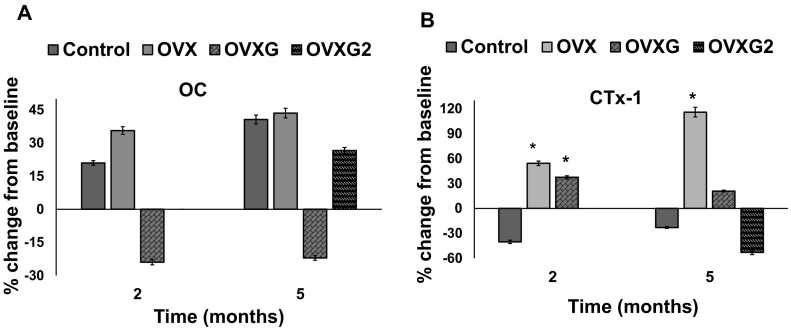
The concentrations of OC and CTx-1 in the serum of the OVX sheep. Percentage change in the bone turnover marker serum OC (A) and percentage change in the bone resorption marker CTx-1 (B) compared with the pretreatment baseline from Merino ewes that were either ovariectomised (OVX), ovariectomised and given five doses of glucocorticoid at monthly intervals (OVXG), ovariectomised and given two doses glucocorticoid at monthly intervals (OVXG2), or received no treatments (Control). OC and CTx-1 were measured at two months and five months after initiation of the treatments. The results are presented as serum OC and CTx-1 mean percent change from baseline. *p-value <0.05. Error bars denote standard error of mean.